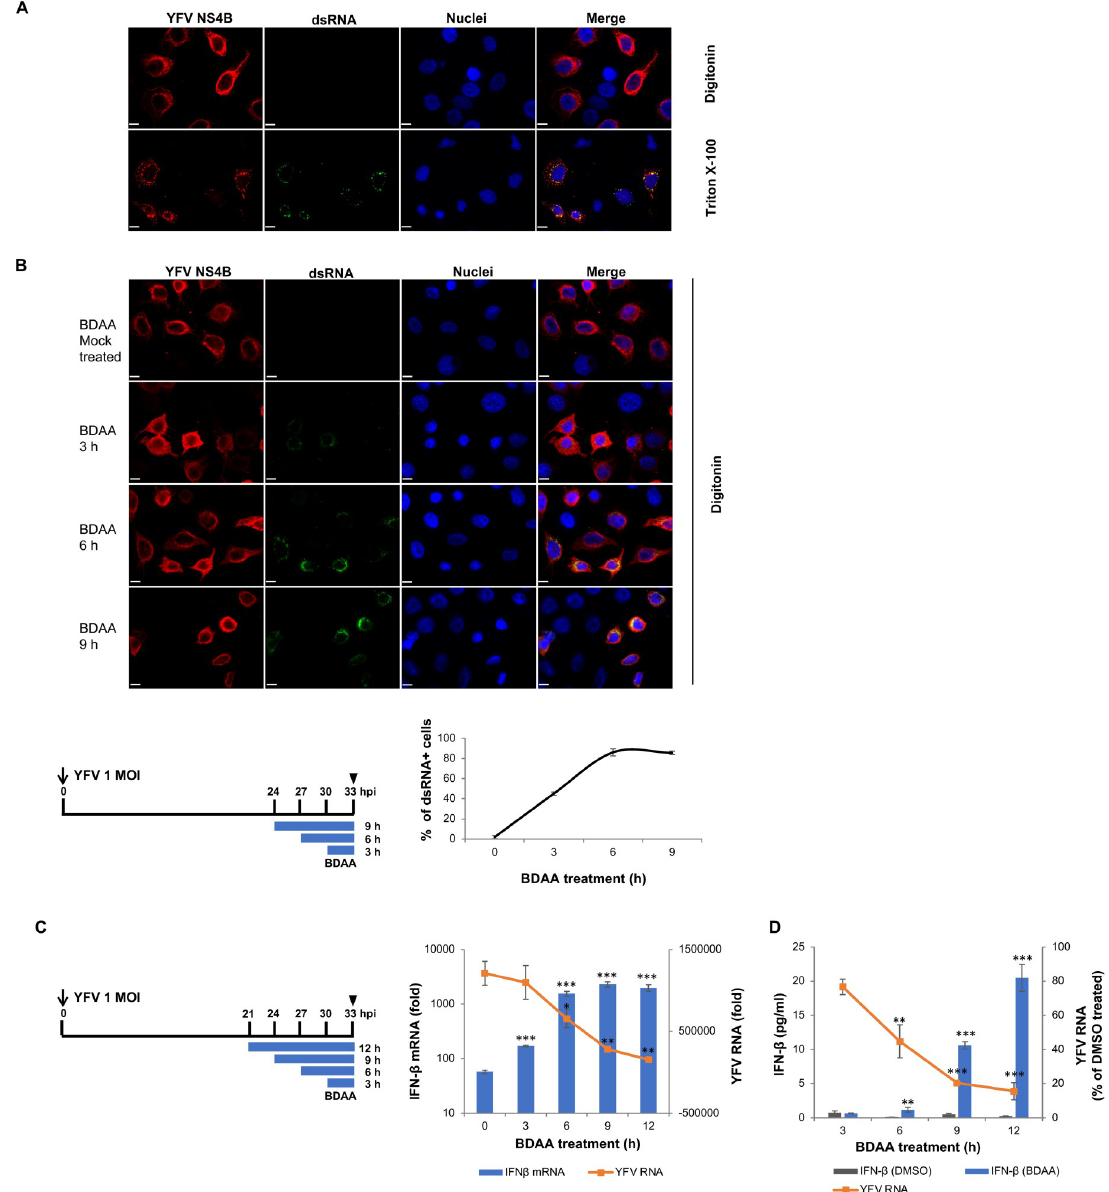
Fig 4. BDAA treatment induces the exposure of dsRNA from digitonin resistant YFV RO. ( A ) Huh7 cells seeded on coverslips in 24-well plate were infected with YFV at MOI of 1. Cells were fixed and permeabilized by digitonin (top row) or Triton X-100 (bottom row) at 24 hpi. YFV NS4B (red) and dsRNA (green) were visualized by immune fluorescence staining. Cell nuclei were stained by DAPI (blue). ( B ) Huh7 cells seeded on coverslips in 24-well plate were infected with YFV at MOI of 1 for 1 h, followed by treatment with DMSO or 5 μ M BDAA at indicated time post infection (as illustrated) for 3, 6, or 9 h. At 33 hpi, cells were fixed and permeabilized with digitonin. YFV NS4B (red) and dsRNA (green) were visualized by immunofluorescence staining. Scale bar is 100 μ m. Numbers of dsRNA positive cells were counted in three independent fields with at least 30 NS4B positive cells per field. Percentage of cells with dsRNA staining in YFV-infected cells (with NS4B staining) were calculated and expressed as average and STDV. (C) Huh7 cells seeded in 24 well plate were infected with YFV at MOI of 1 for 1 h followed by treatment with DMSO or 5 μ M of BDAA starting at indicted time for 3, 6, 9, or 12 h (as illustrated). Total cellular RNA was extracted at 33 hpi. YFV RNA and IFN- β mRNA were measured by qRT-PCR and expressed as fold relative to that in uninfected cells. Values represent average and standard deviation from 4 independent experiments. � indicates P < 0.05, �� indicates P < 0.01, ��� indicates P < 0.001 compared to no treatment controls. (D) Huh7 cells seeded in 96 well plate were infected with YFV at MOI of 1 for 1 h followed by treatment with DMSO or 5 μ M of BDAA, starting at the indicted time for 3, 6, 9, or 12 h (as illustrated in panel C). Supernatants were harvested at 33 hpi to measure the secreted IFN- β . Values were determined after normalization to standard curve and express as average and standard deviation from 3 independent experiments. Total cellular RNA was extracted at 33